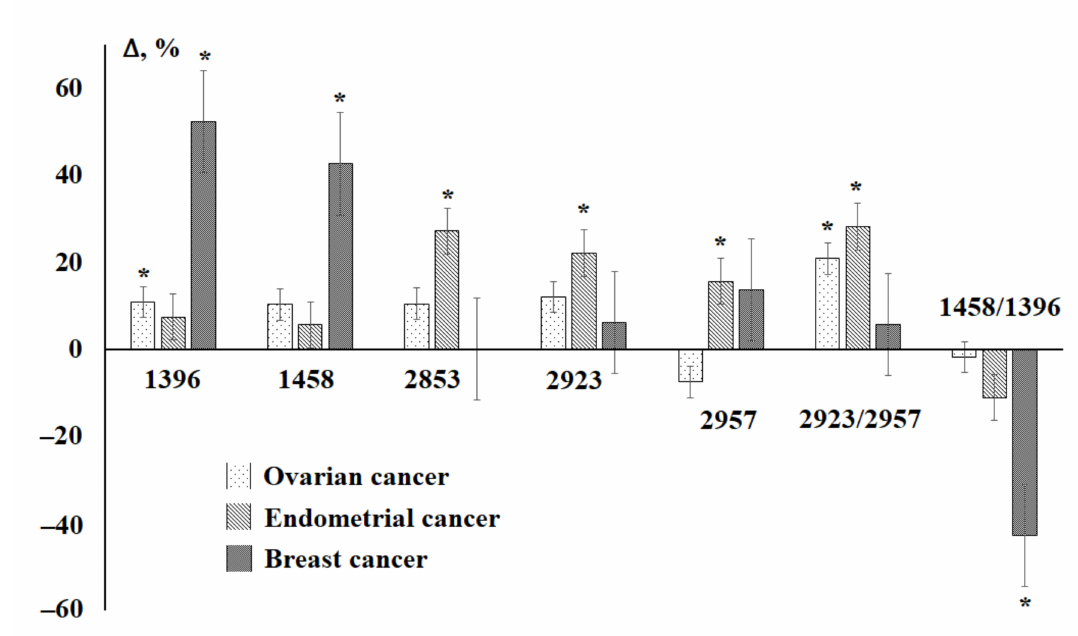
Figure 7. Relative changes in the intensities of the absorption bands of the salivary IR spectra in ovarian, endometrial and breast cancer. *—differences in comparison with the control group are statistically significant, p < 0.05.